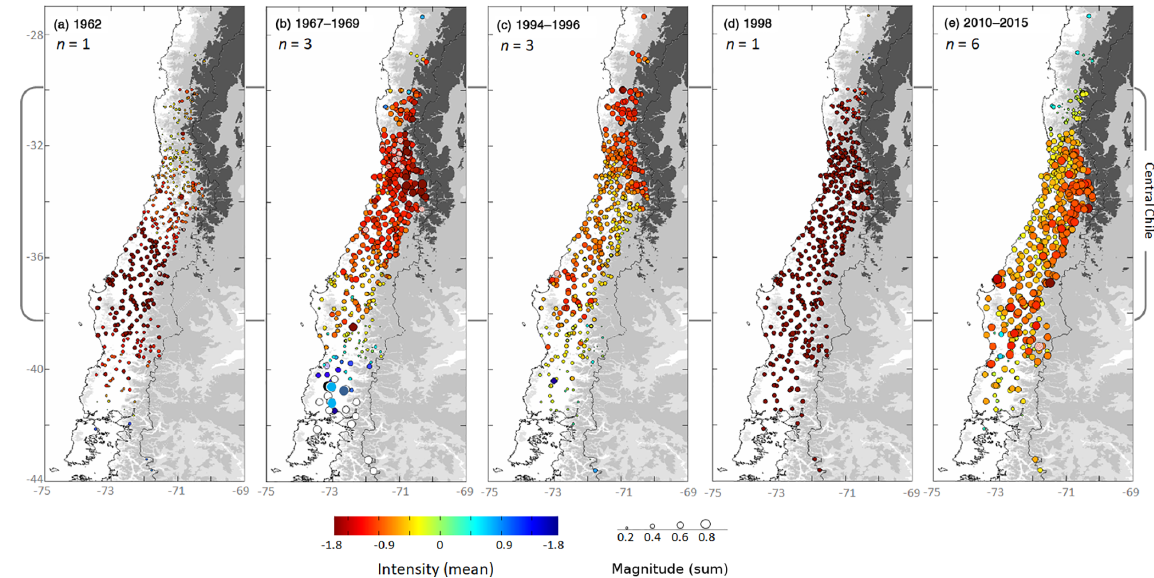
Figure 4. Station-based, standardized precipitation index (December values of SPI12) for selected droughts. For multi-year droughts, the size of the symbol represents its magnitude (sum of SPI12-D) and the color its intensity (average of SPI-12D).